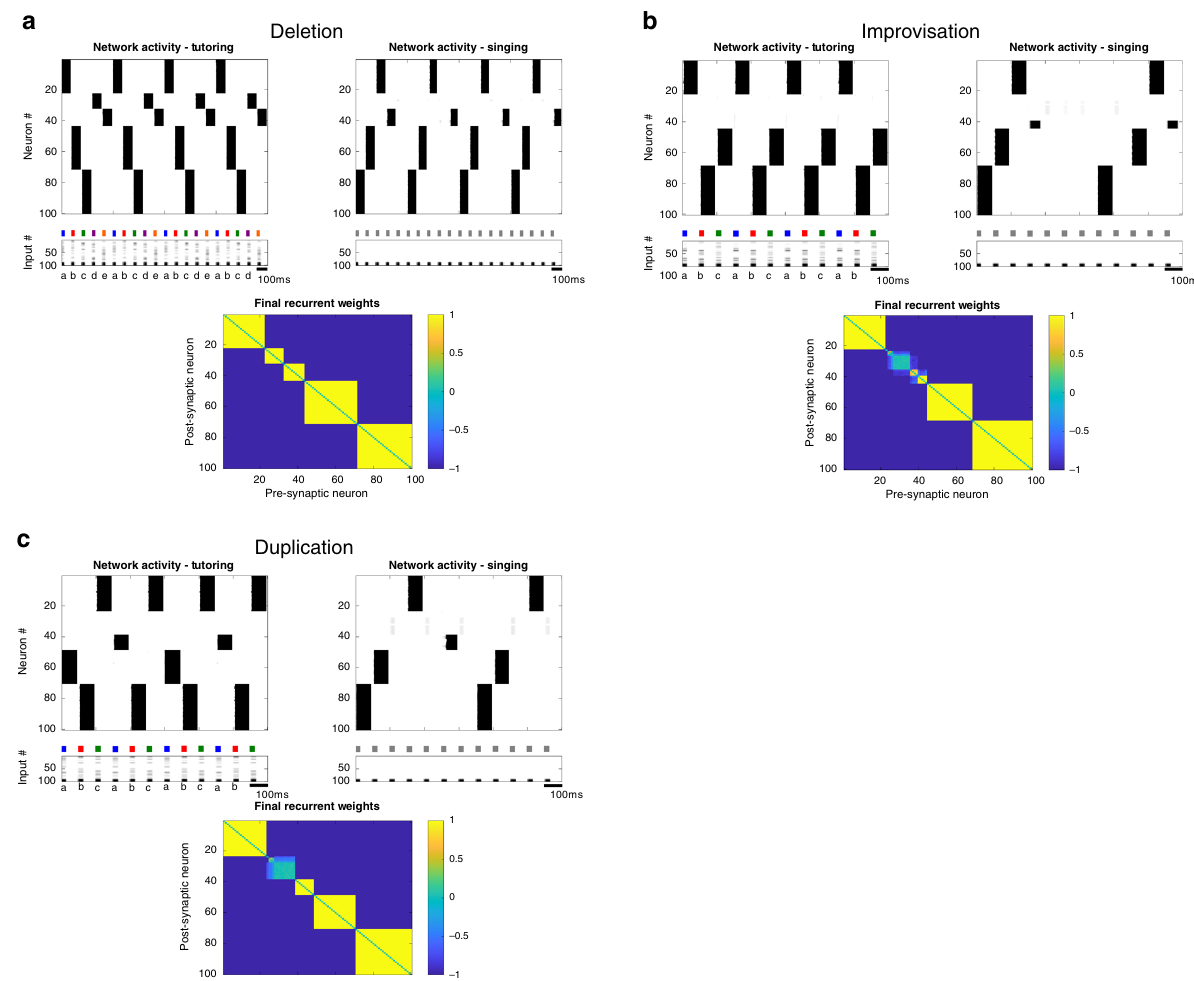
Fig. 9 NIf model recapitulates interesting failure modes of vocal learning. Under some circumstances, the model demonstrated failures of imitation, including deletion of a tutor syllable, improvised syllables, and duplicated syllables. Network activity during tutoring and singing, and fi nal weight matrix, are shown for several interesting cases: a A case in which the network failed to reactivate, during the singing phase, an ensemble formed during tutoring (deletion). In this example, the network was tutored with fi ve syllables. The network produced fi ve ensembles during tutoring, but only four are successfully activated during singing. b A case in which the network spontaneously generates an un-tutored syllable during the singing phase (improvisation). Here, the network was tutored with three syllables. All three corresponding ensembles are activated during singing, as well as a fourth ensemble corresponding to leftover NIf neurons. c A case in which the network creates two distinct ensembles corresponding to the same tutor syllable (duplication). Here, the network was tutored with three syllables ( ‘ a ’ , ‘ b ’ , and ‘ c ’ ). The network formed two different ensembles for tutor syllable ‘ a ’ (neurons 49 – 70, and neurons 39 – 48), activated on alternate presentations of the syllable ‘ a ’ . These two distinct ensembles are both replayed during singing, and in our model, would drive the formation of two different syllable sequences in